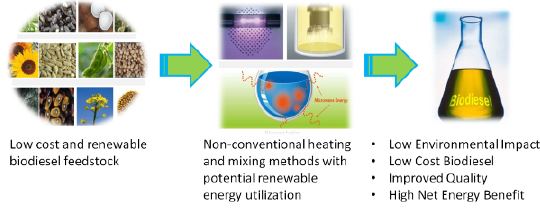
Figure 1. Potential pathways for sustainable biodiesel